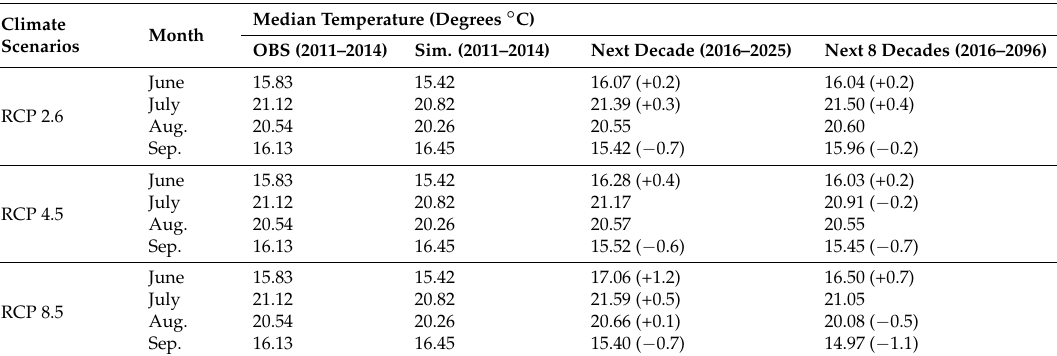
Table 3. Median daily water temperature with RCP climate scenarios.